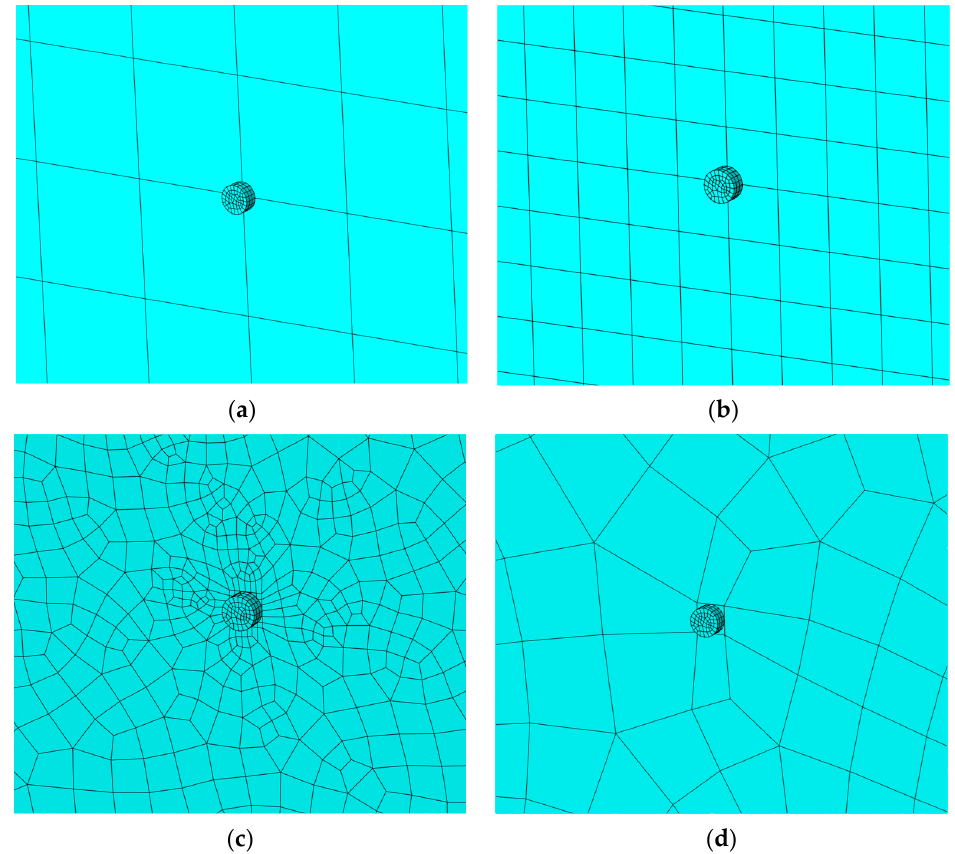
Figure 7. Glass pane mesh near the support pillar for the following mesh sizes: ( a ) 2.5 mm; ( b ) 1.0 mm; ( c ) 1.0 mm (0.1 mm near the support pillars); and ( d ) 2.5 mm (0.5 mm near the support pillars). Shapes of the support pillars’ deformations in first natural frequencies associated with out-of-phase vibrations for obtained mesh sizes are shown in Figure 8, respectively.